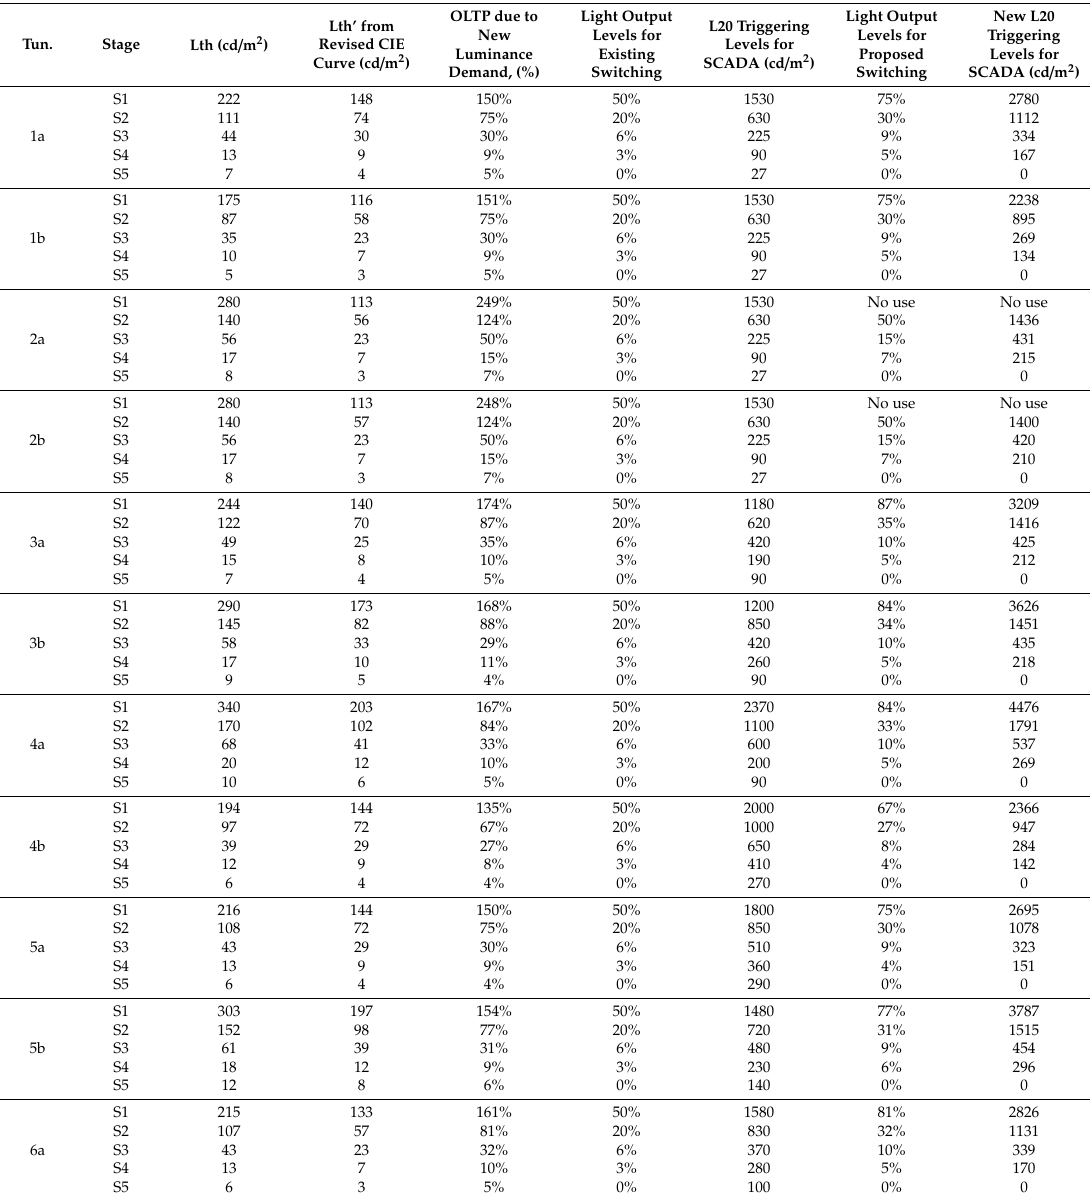
Table 8. Comparison of the switching control between Scenario A (switching control with existing Lth values) and Scenario B (switching control with new proposed Lth’ values) for all examined tunnels. OLTP = Over Lit Triggering